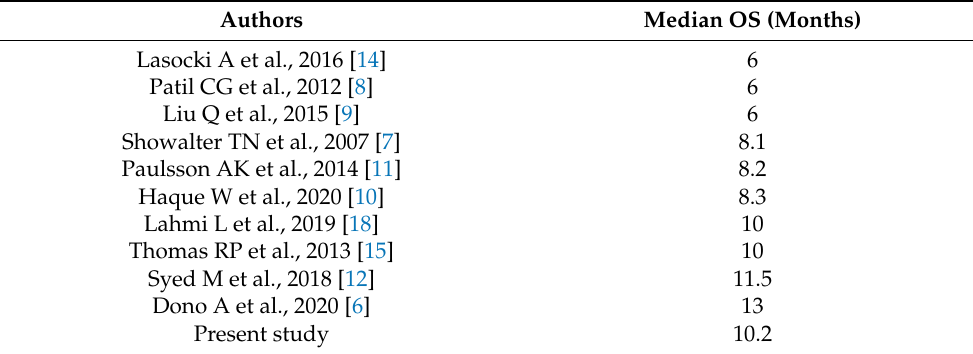
Table 6. The median OS of GBM patients with multiple lesions at the time of diagnosis according to the present study and those in the